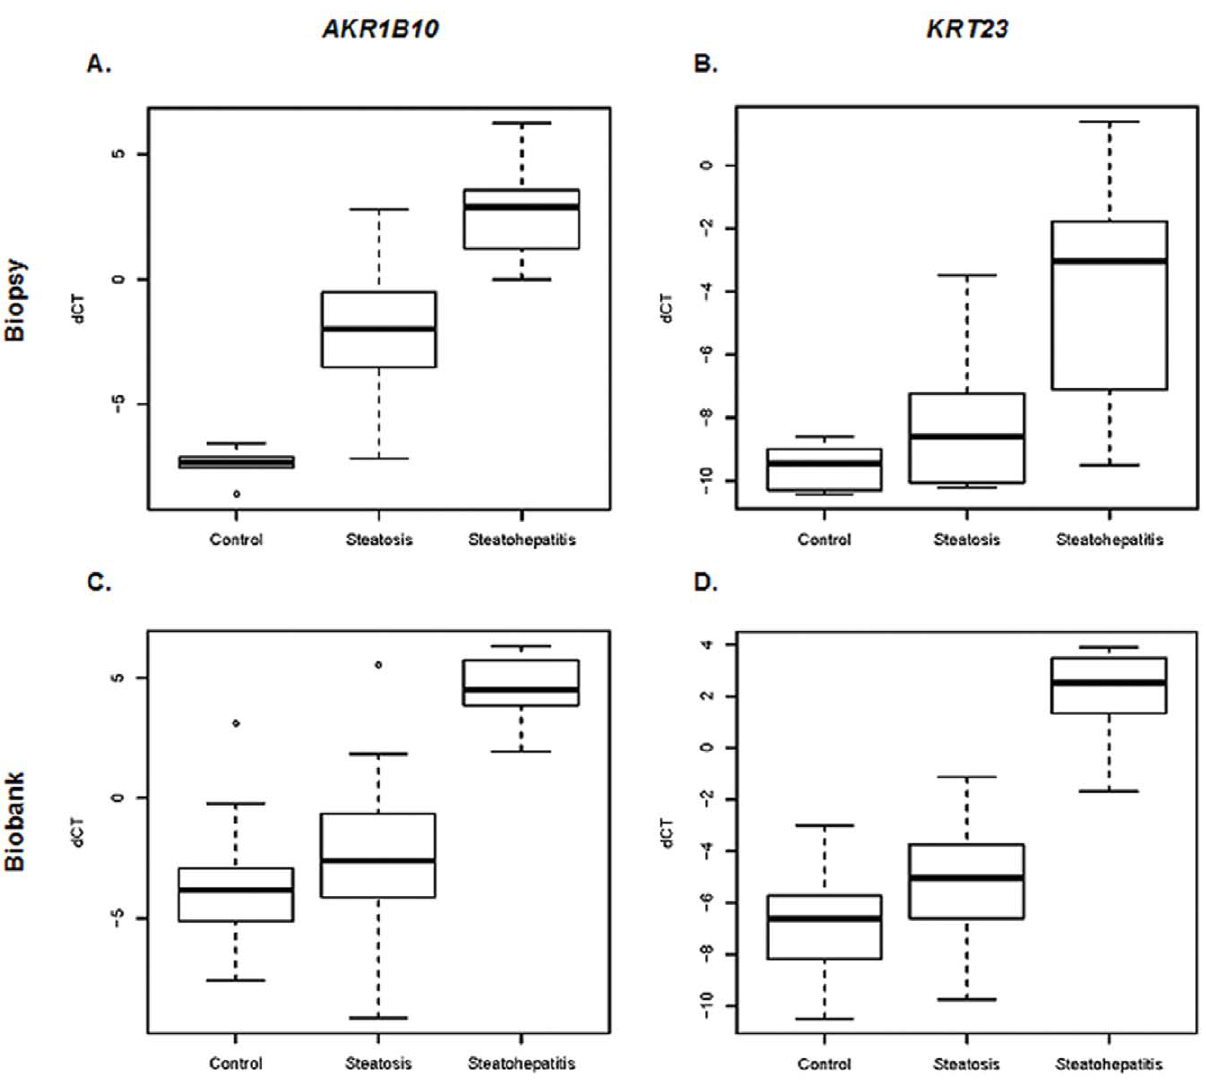
Figure 3. Validation of AKR1B10 (A and C) and KRT23 (B and D) mRNA expression by qRT-PCR in biopsy (top) and biobank (bottom) samples. HPRT1 was chosen to normalize the gene expression in the analyzed samples. Mean normalized expression levels are given in log2.